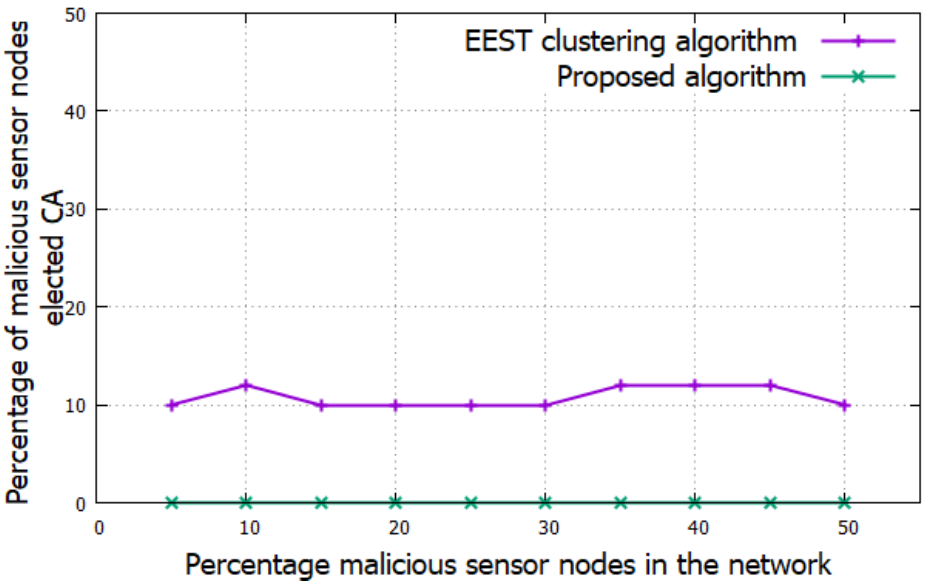
Figure 4. Number of CA as a function of the percentage of malicious sensor nodes in the network.